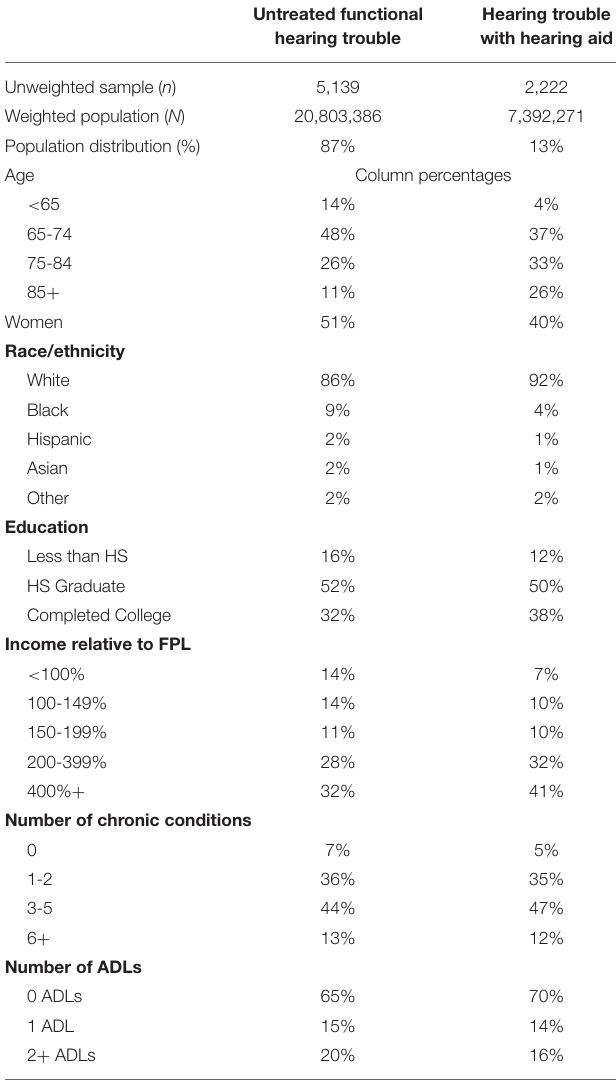
TABLE 1 | Characteristics of Medicare beneficiaries with functional hearing trouble by hearing aid